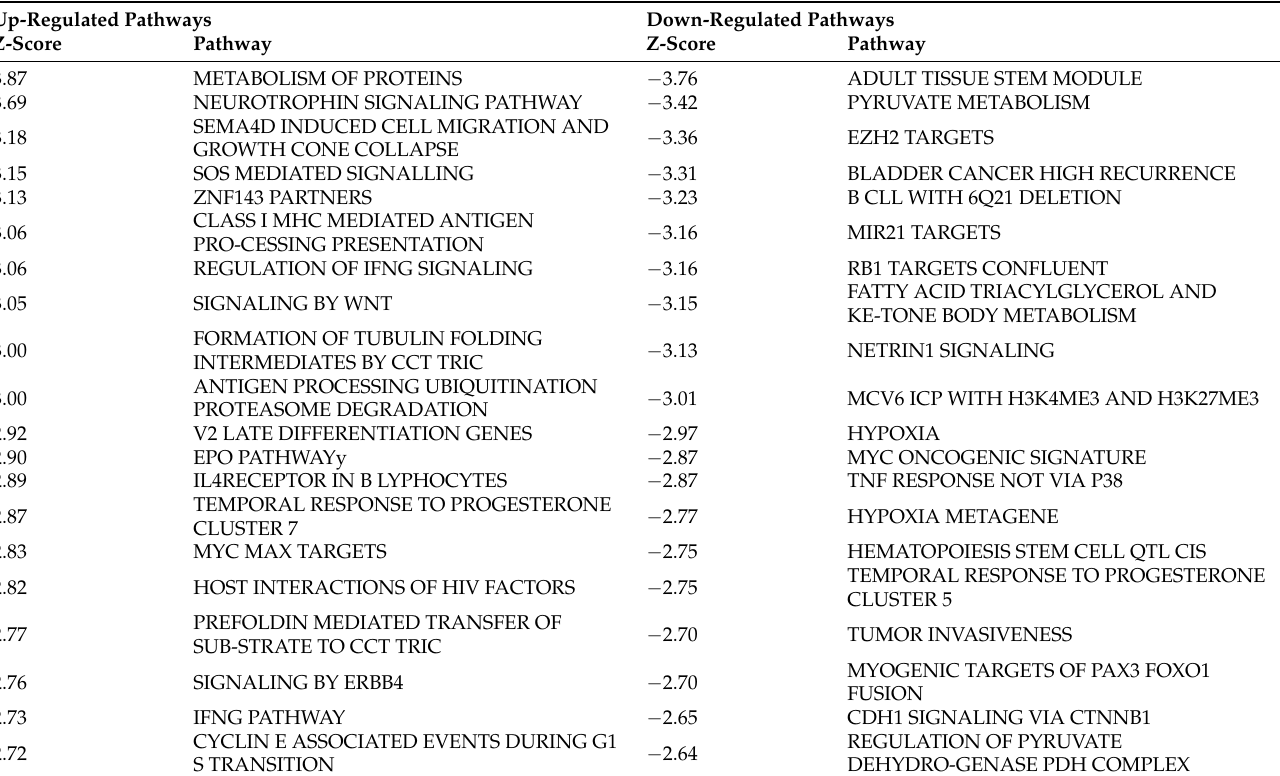
Table 4. The positive and negative enrichment of pathways in the AM630 transcriptional response of the invasive cell population. The invasive margin response is associated with the enrichment of distinct pathways relative to the core cell response. Of note, are the down regulation of the tumour invasiveness and MYC pathways, indicating a possible anti-neoplastic activity. See Table S5 for a full list of enriched